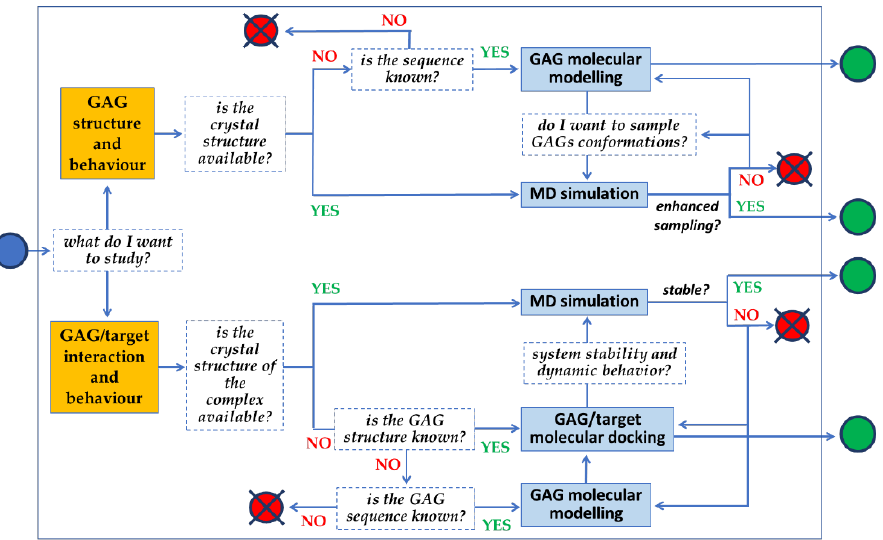
Figure 8. Flowchart schematizing the series of queries in an application of computational approaches aimed at a comprehensive characterization of a GAG or a GAG/target complex.